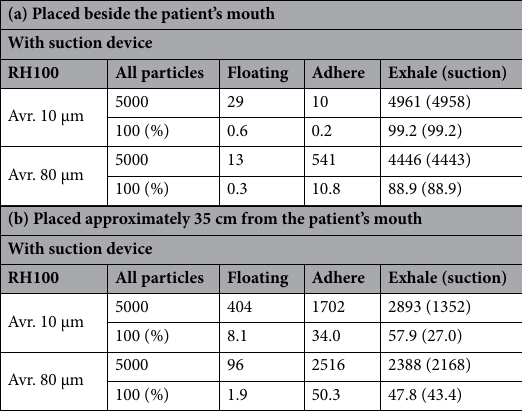
Table 4. The relative proportions of suspended, deposited, exhaled, and suctioned particles with a suction device placed (a) beside and (b) 35 cm from the patient’s mouth as shown in Fig. 3, 100 s after the patient begins exhaling at a constant rate of 2.5 m/s (Case X) at